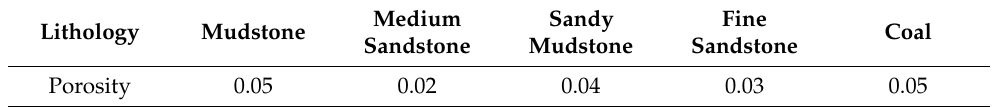
Table 4. Initial porosity of certain rock strata.